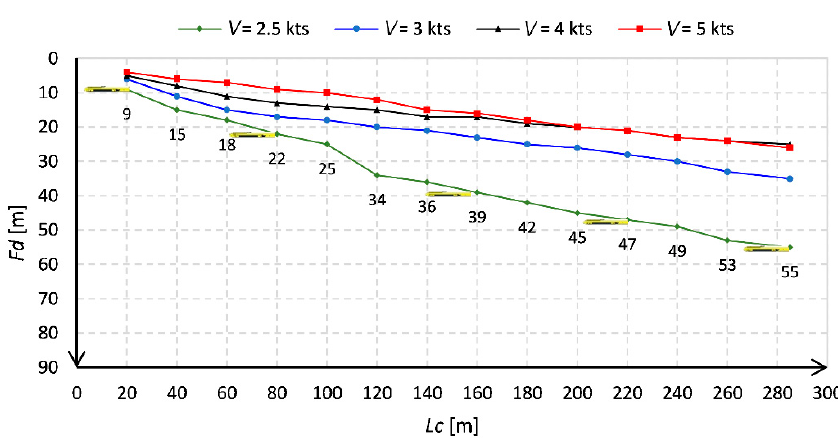
Figure 6. Towfish depth as a function of cable length and towing speed. L c is a length of tow cable loosened behind the stern [m]; Fd is a towfish depth (distance from sea surface to the sonar [m]; V is the speed of towing [kts].